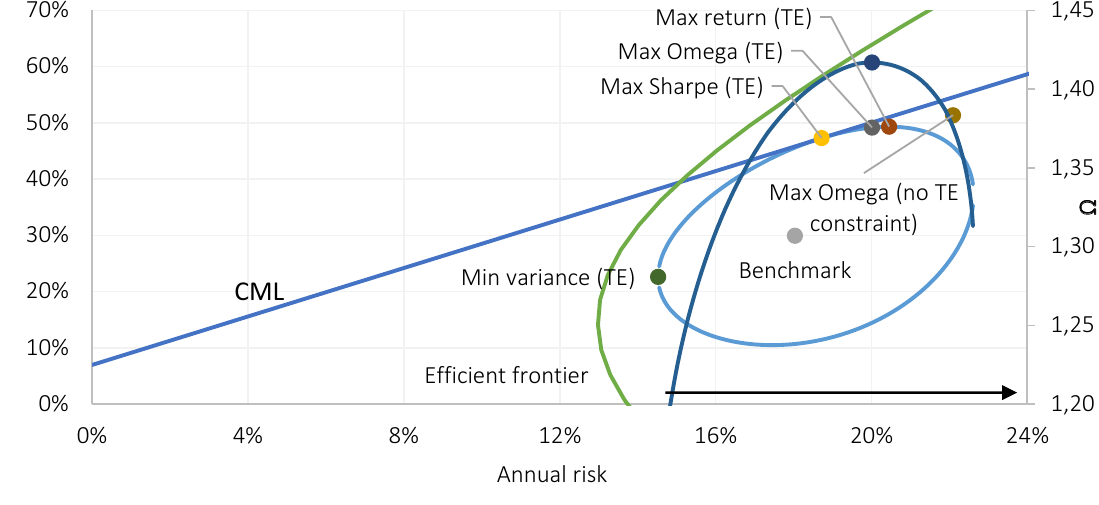
= 7.0%. The Ω – ratio as a f